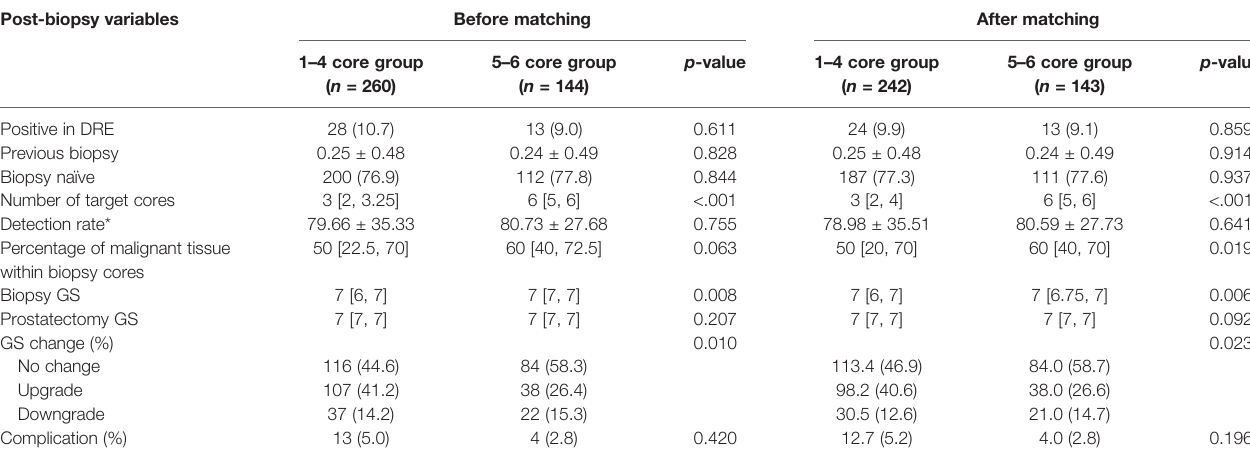
TABLE 3 | Biopsy and prostatectomy fi ndings before and after propensity score matching. Post-biopsy variables Before